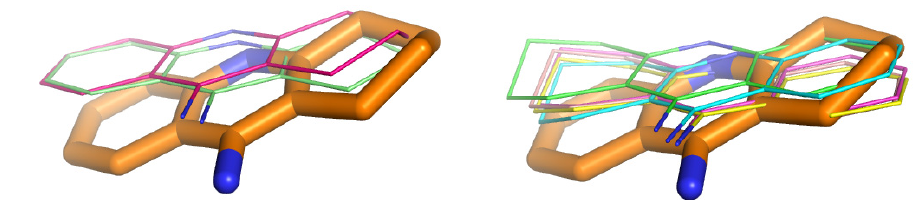
Figure 6. Tacrine clusters obtained in docking to BuChE. Results were compared with the arrangement of tacrine (orange) in the complex with acetylcholinesterase.